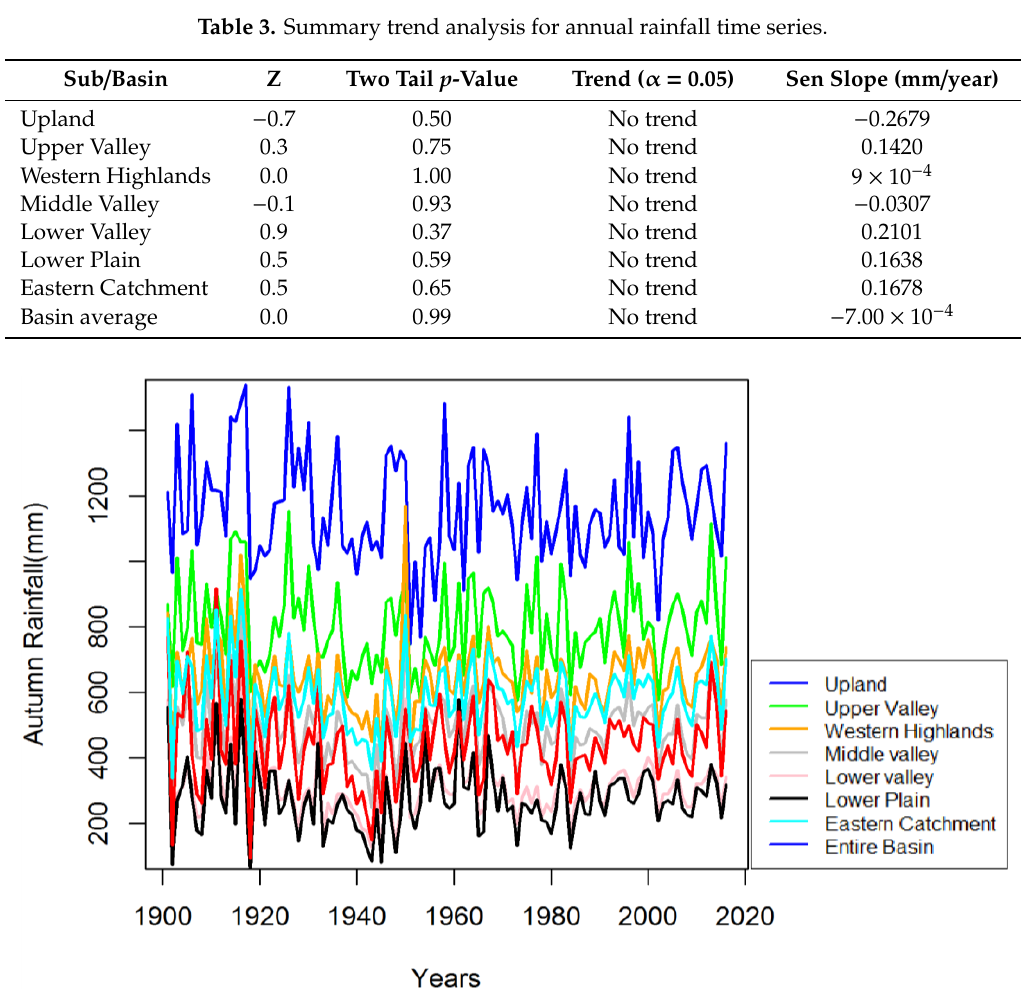
Figure 7. Annual rainfall time series for the sub-basins for the period 1900 – 2016.